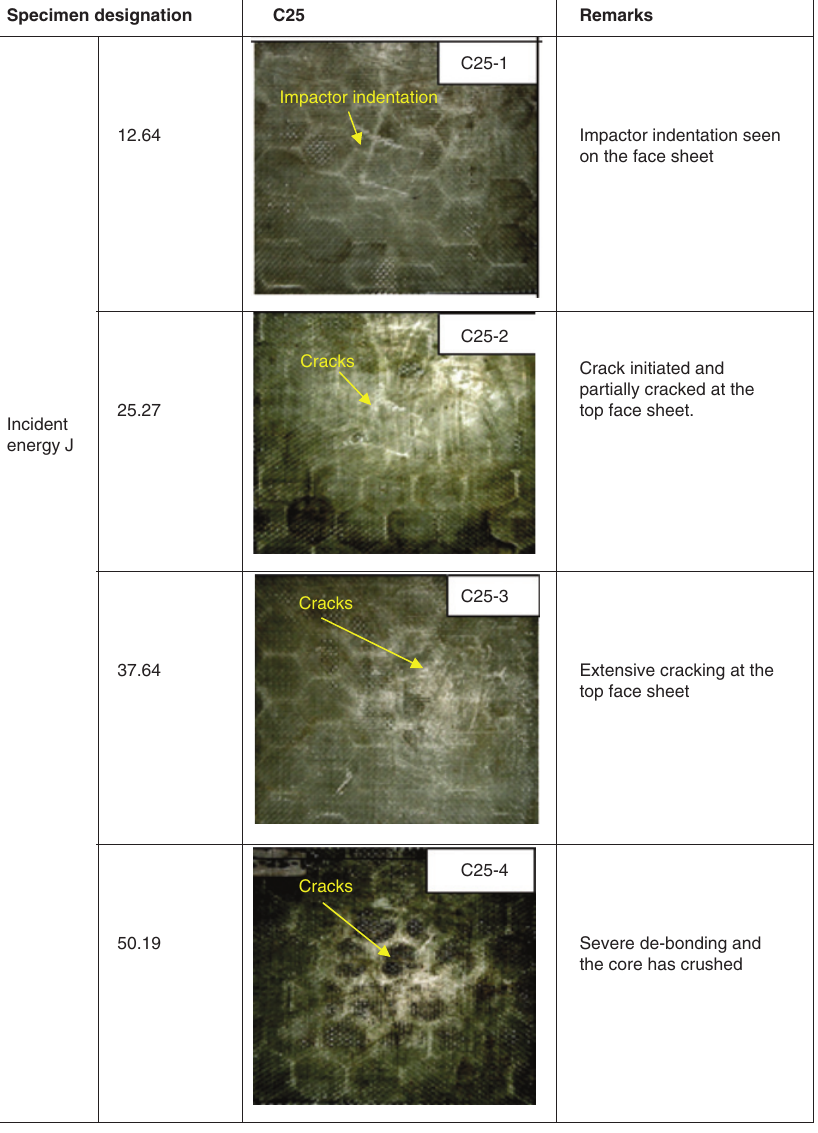
Figure 14 Post-impact images of specimen C25 at various energy